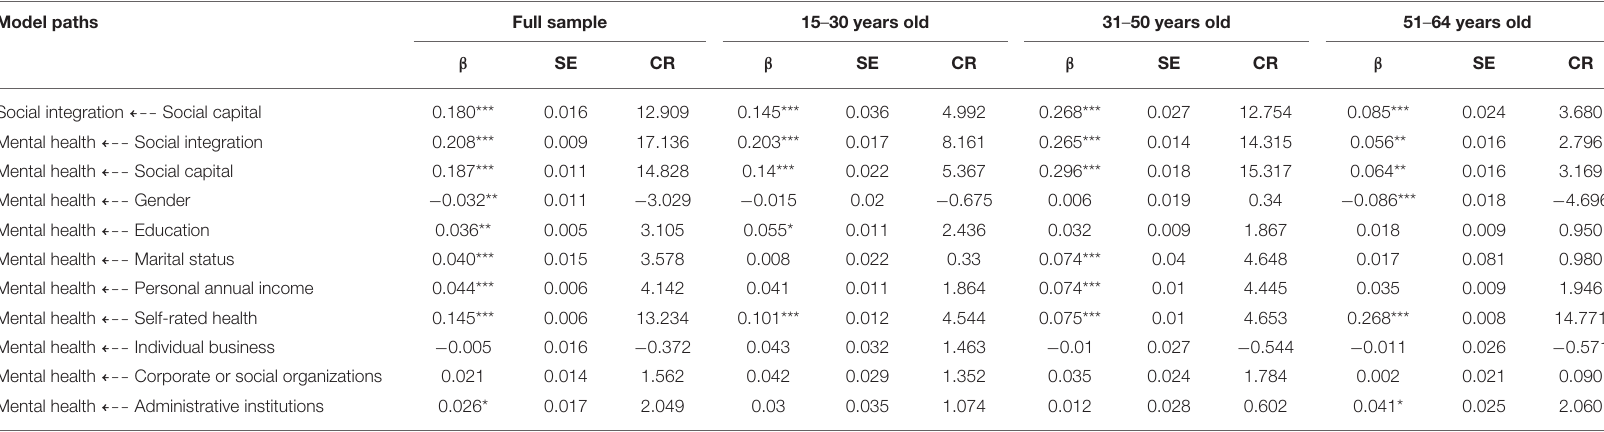
TABLE 3 | Results of structural model for full sample and subsamples.